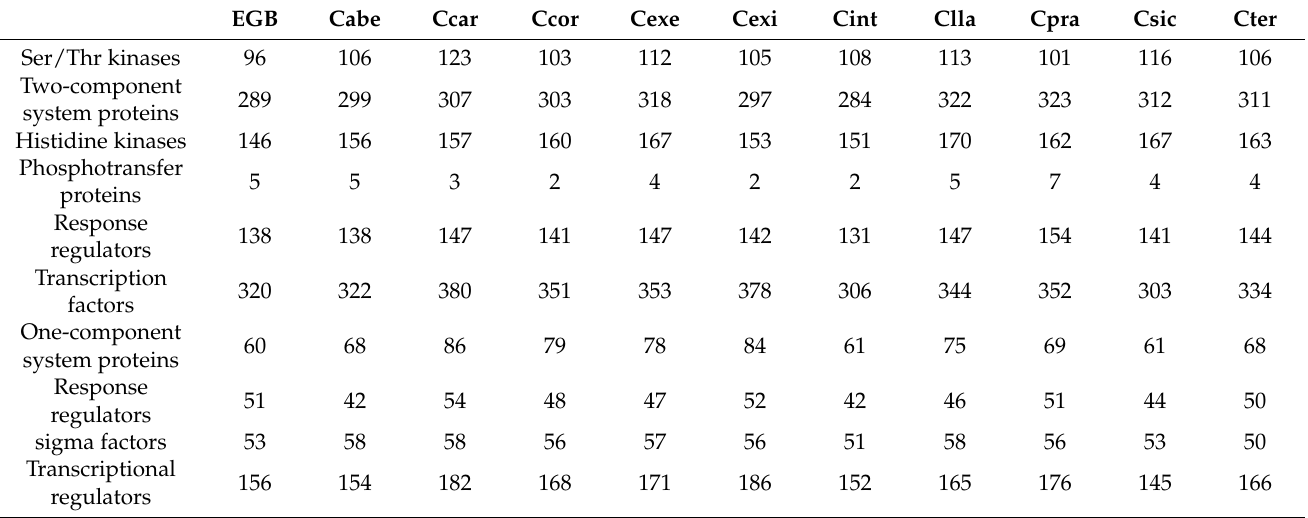
Table 3. Variability in the numbers of regulatory genes per